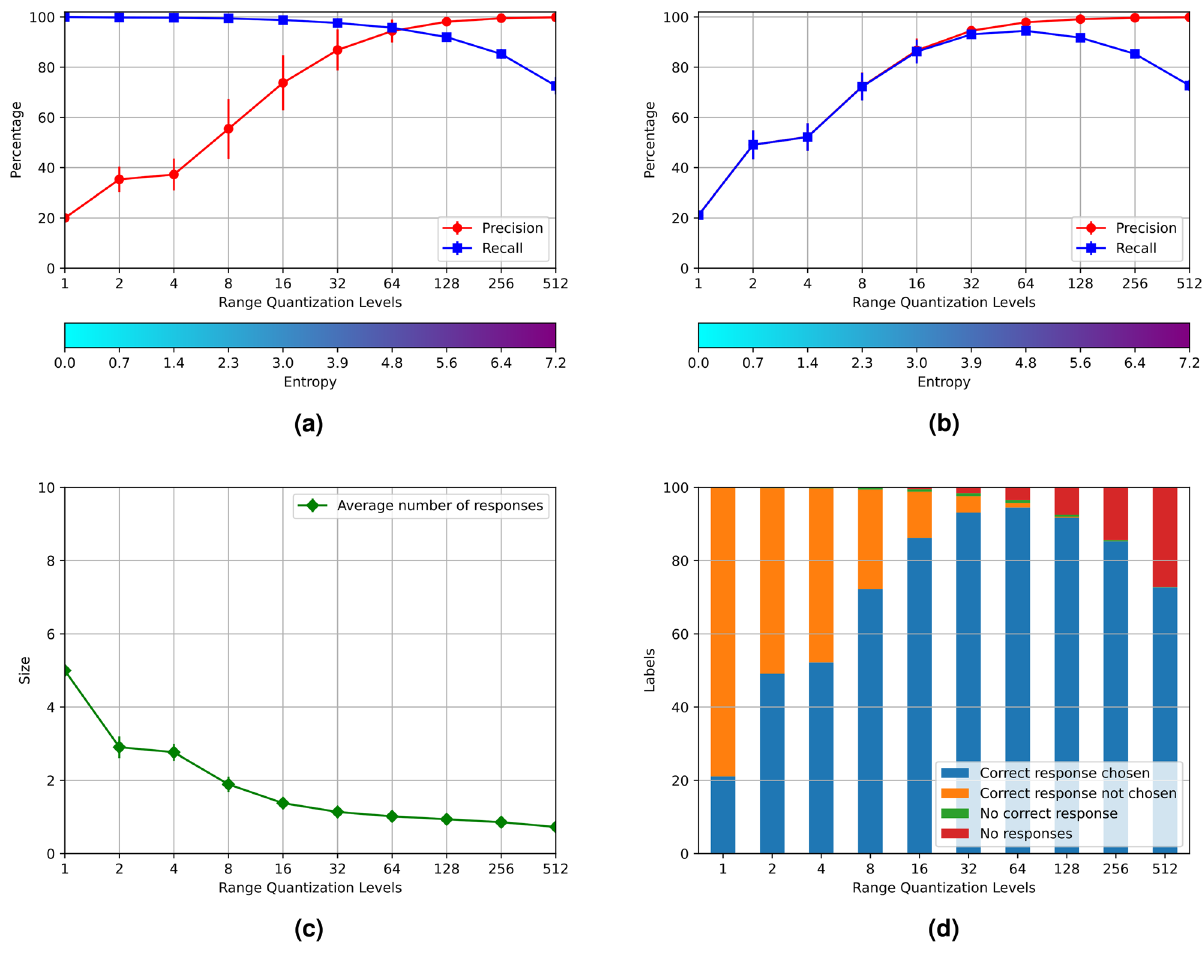
Figure 4. Results of experiment